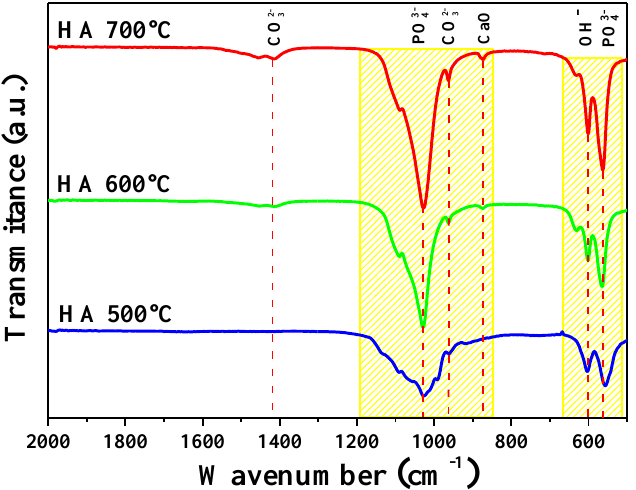
Figure 2. FTIR-ATR spectrum of the three HA samples synthesized at different temperatures.